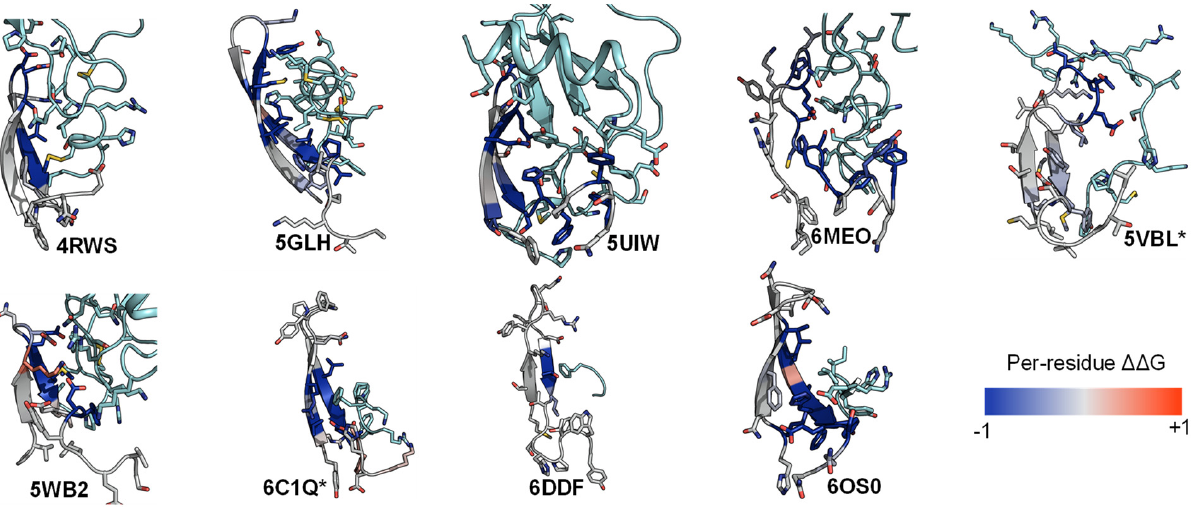
Figure 6. ECL2 β -hairpin and conserved residues interact with peptides of nine peptide/class A GPCR crystal structures.